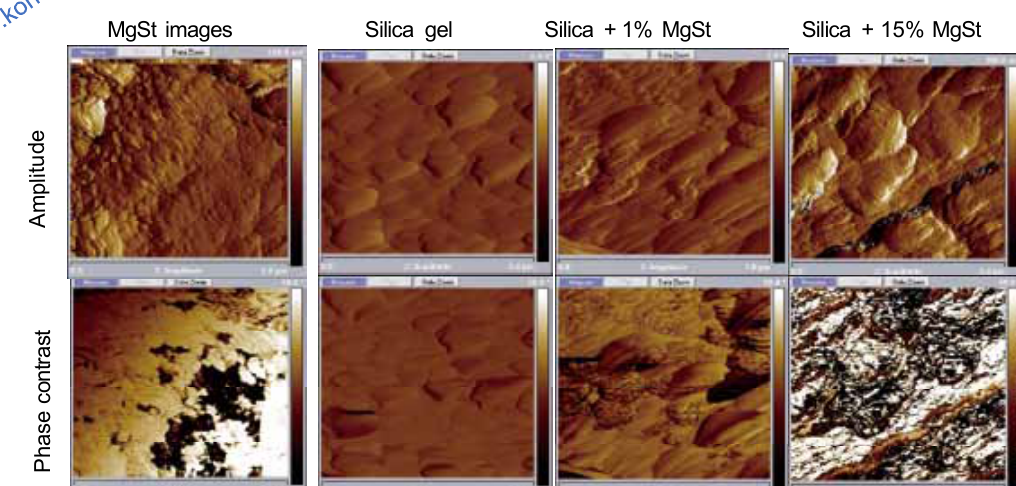
, silica gel and silica coated with 1% and 15 % initial mass ratios of MgSt 2